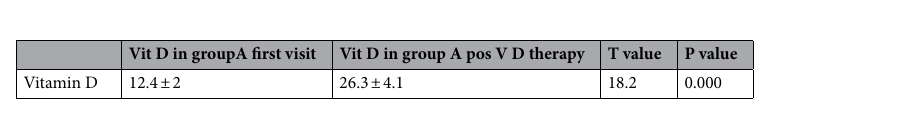
Table 3. Comparison between vitamin D level in group A in pre and post vitamin D